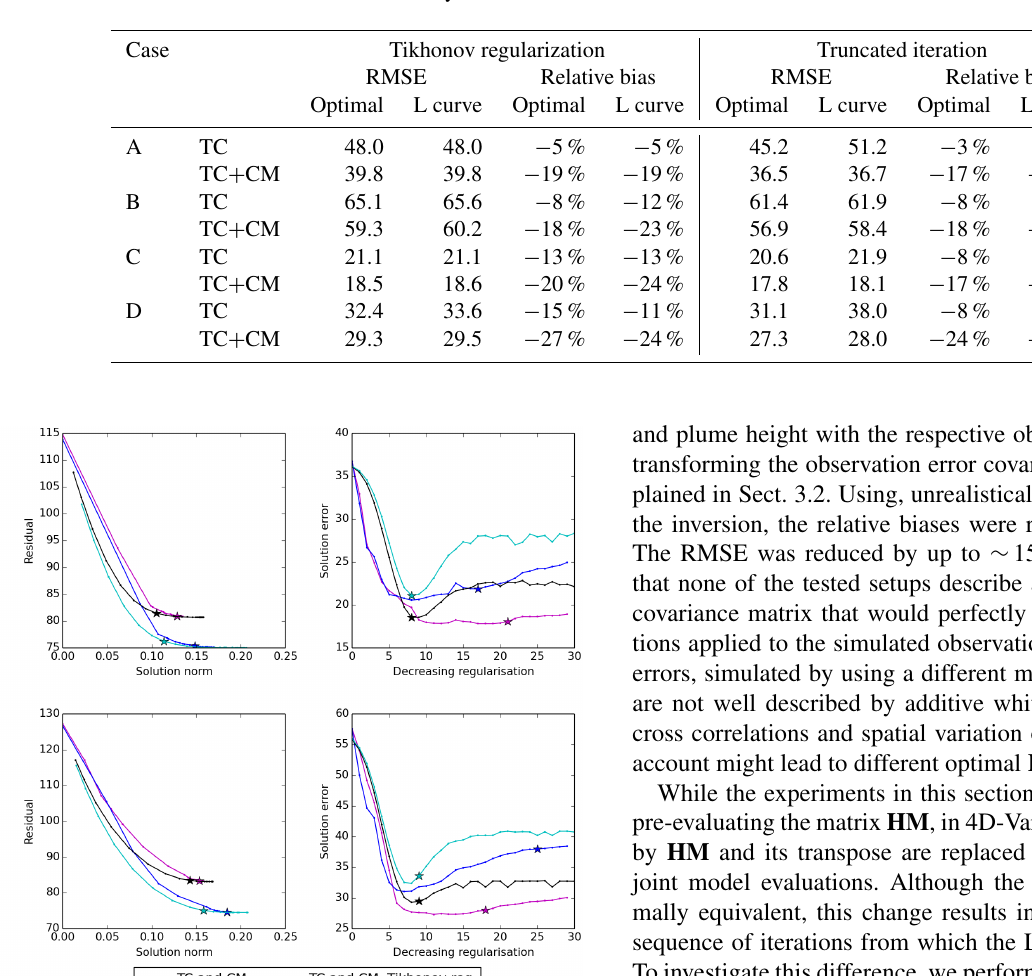
Table 1. Bias and RMSE with respect to the true source term (cases A–D) in experiments with synthetic data with assimilation of total column (TC) and total column and plume height (TC plus CM). Values are shown for both optimal regularization (regularization parameter or iteration number with the lowest RMSE) and for the regularization chosen from the L curve. Relative bias is defined as the difference between estimated and true total emission divided by the true total emission.